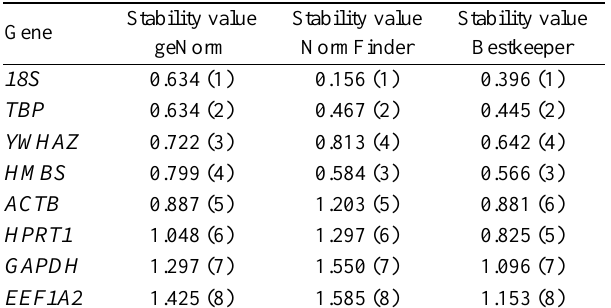
Table 3. Expression stability values of the candidate reference genes calculated by geNorm, NormFinder and Bestkeeper